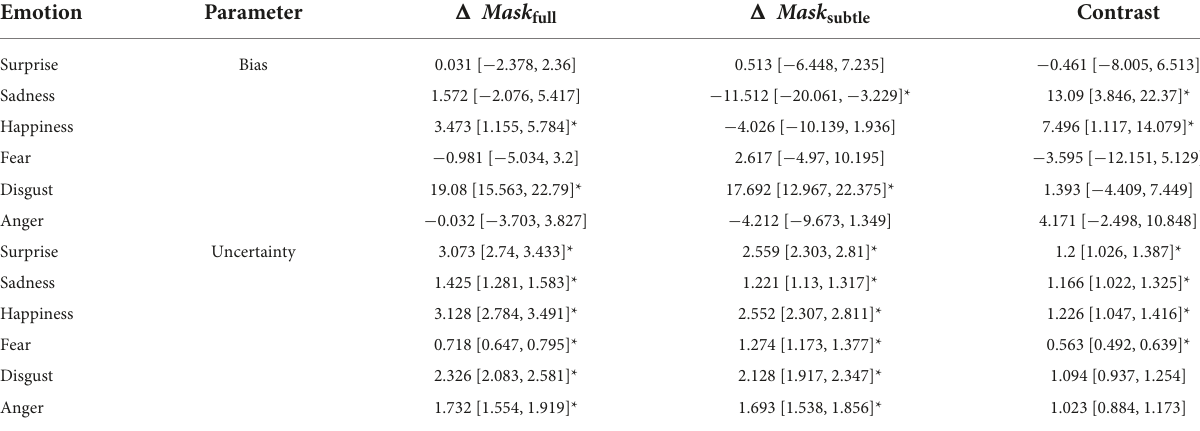
TABLE 2 Posterior distribution summaries for the bias and uncertainty Facial Expression Intensity effect as a function of the displayed